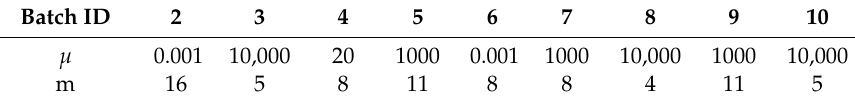
Table 3. Parameter values of the DCKT under Experimental Setting 1.